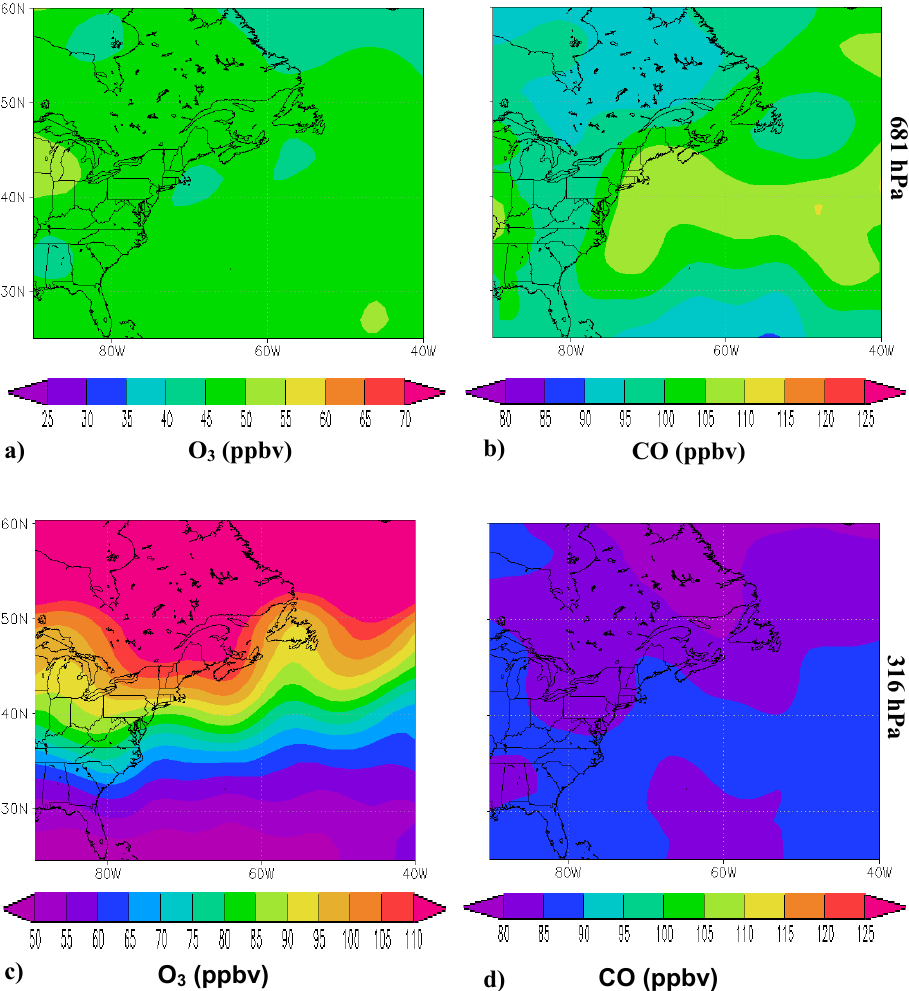
Fig. 2. The DJF seasonal composites for (a) 681hPa O 3 (ppbv) (b) 681hPa CO (ppbv), (c) 316hPa O 3 (ppbv) and (d) 316hPa CO (ppbv).